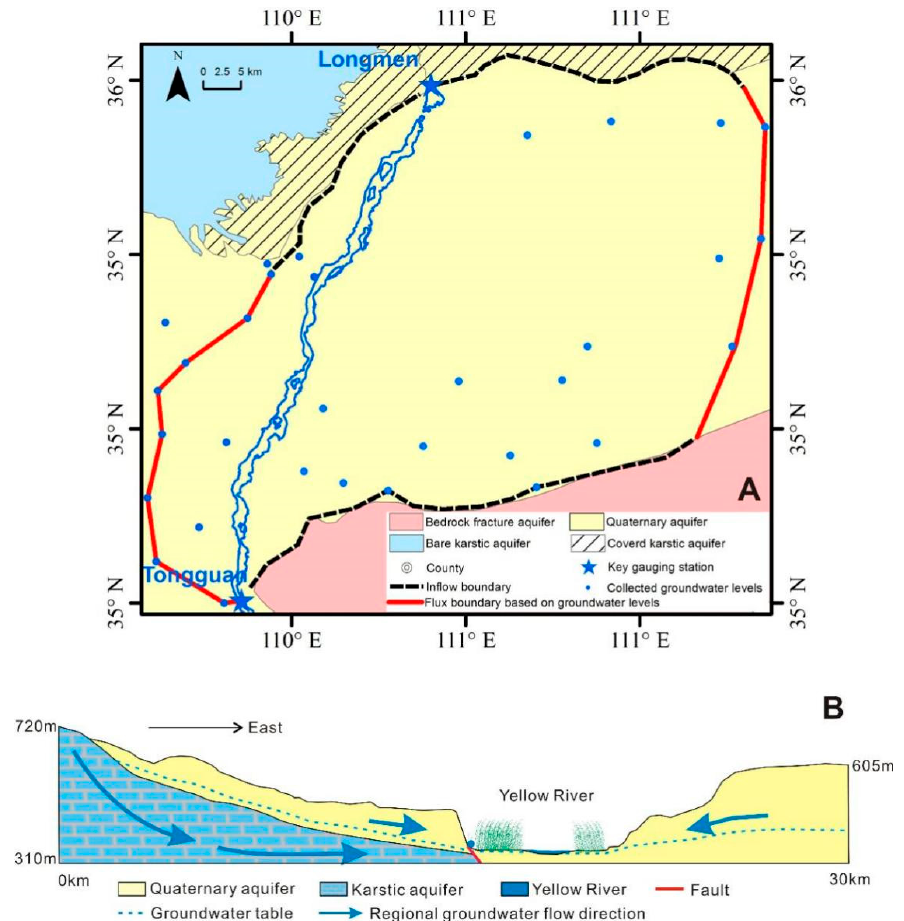
Figure 2. Hydrogeological units in study area(A), and the generalized cross-section across the Yellow River(B), showing the distribution of the main units and the generalized regional groundwater flow paths.